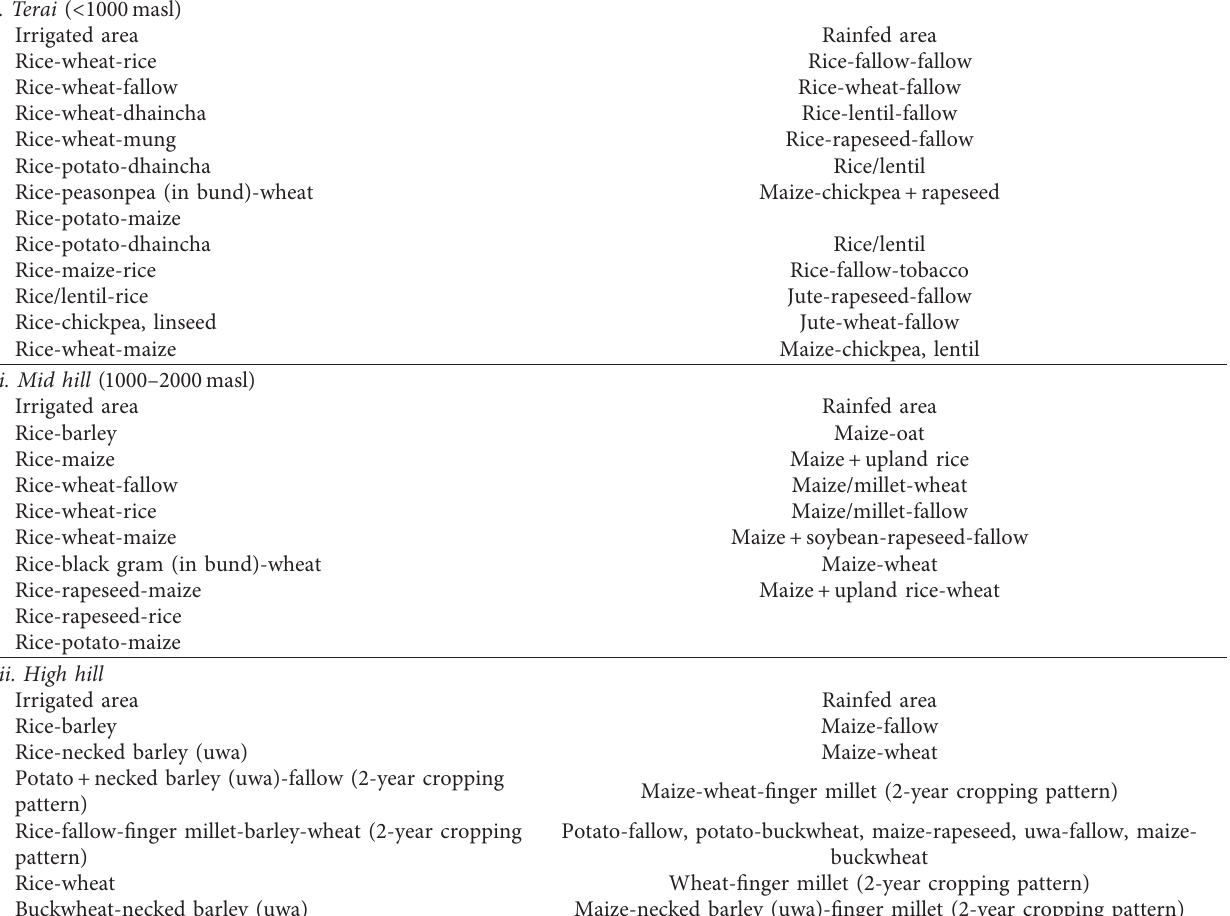
Figure 1: Conceptual framework of importance of DCR in food security and soil health maintenance. Table 1: Major crop rotation in